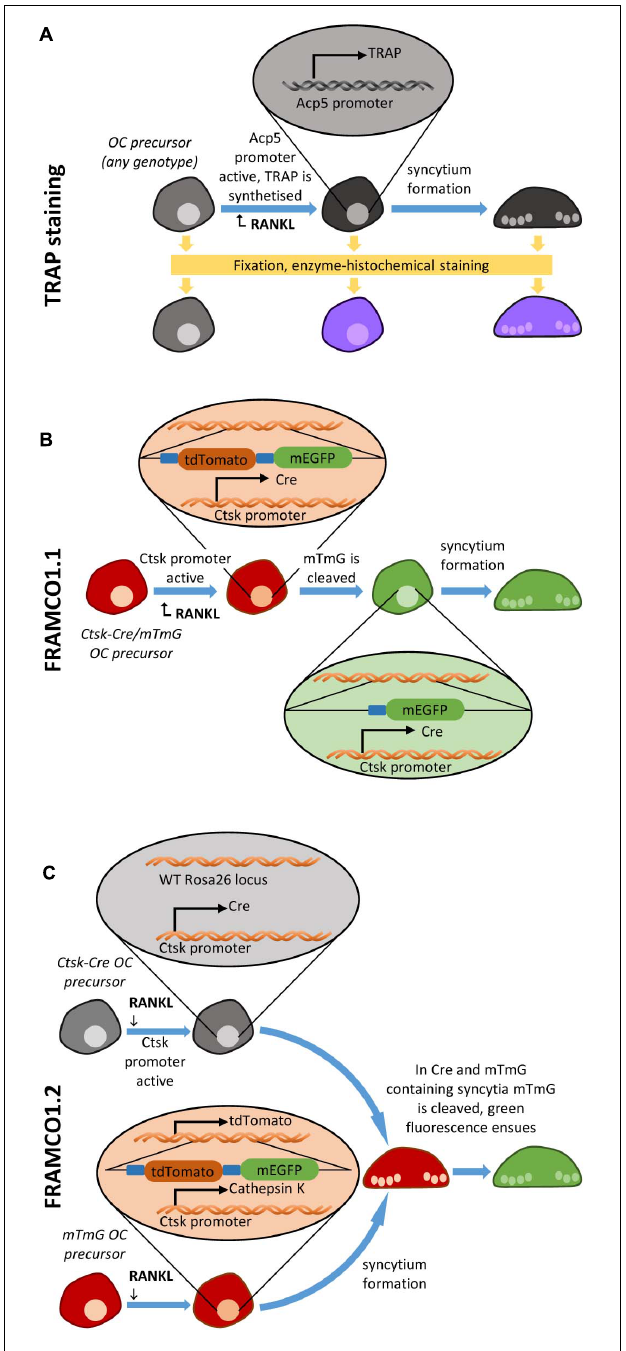
FIGURE 1 | Overview of osteoclastogenesis assays. Schematic depiction of (A) the TRAP staining-based osteoclast detection, (B) the fluorescent Ctsk-Cre/mTmG-based (FRAMCO1.1) Ctsk-reporter system for the analysis of osteoclast-specific gene expression, and (C) the Ctsk-Cre + mTmG co-culture based (FRAMCO 1.2) fluorescent intercellular fusion assay.